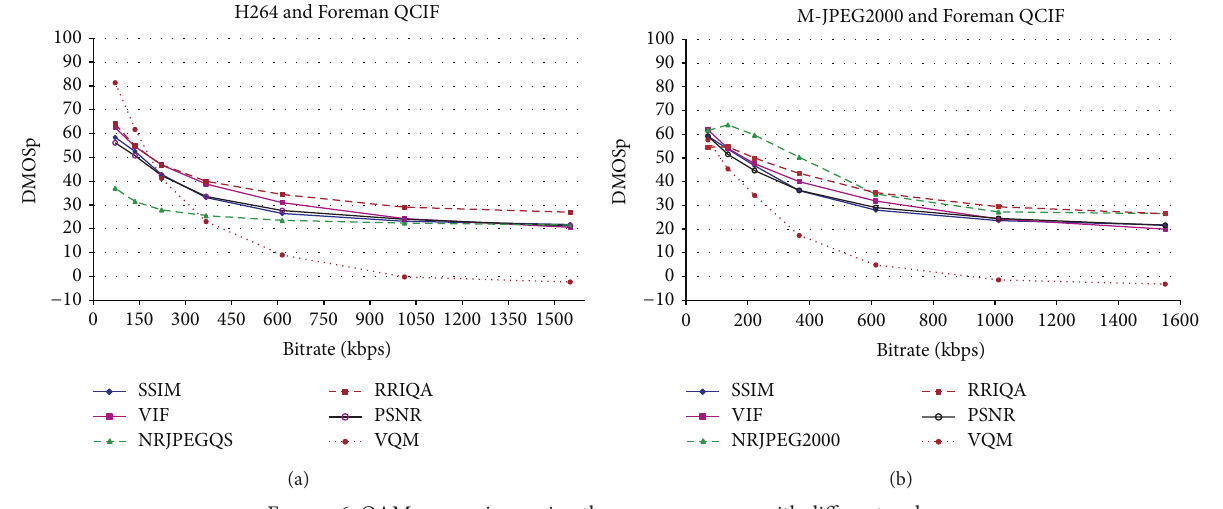
Figure 6: QAM comparison using the same sequences with different